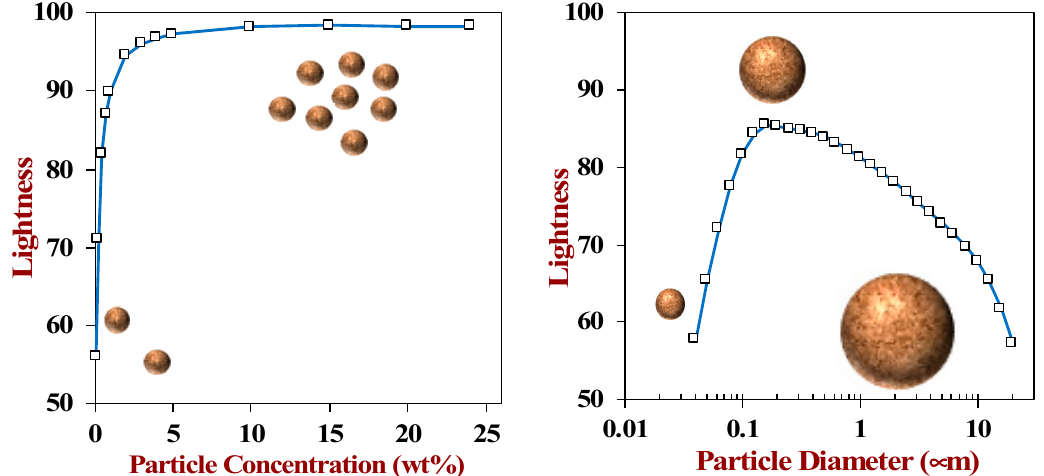
Figure 2. The lightness of a plant-based milk substitute is dependent on the size and concentration of any particulate matter that scatters light. The theoretical predictions of lightness were made by the author using light scattering theory for oil droplets dispersed in water. Table 1. Comparison of the physicochemical and structural properties of various plant-based milks: Apparent shear viscosity, flow index, mean particle diameter (D 32 and D 43 ), gravitational separation rate, and whiteness index. The data was extracted from a previously published work by Jeske and others